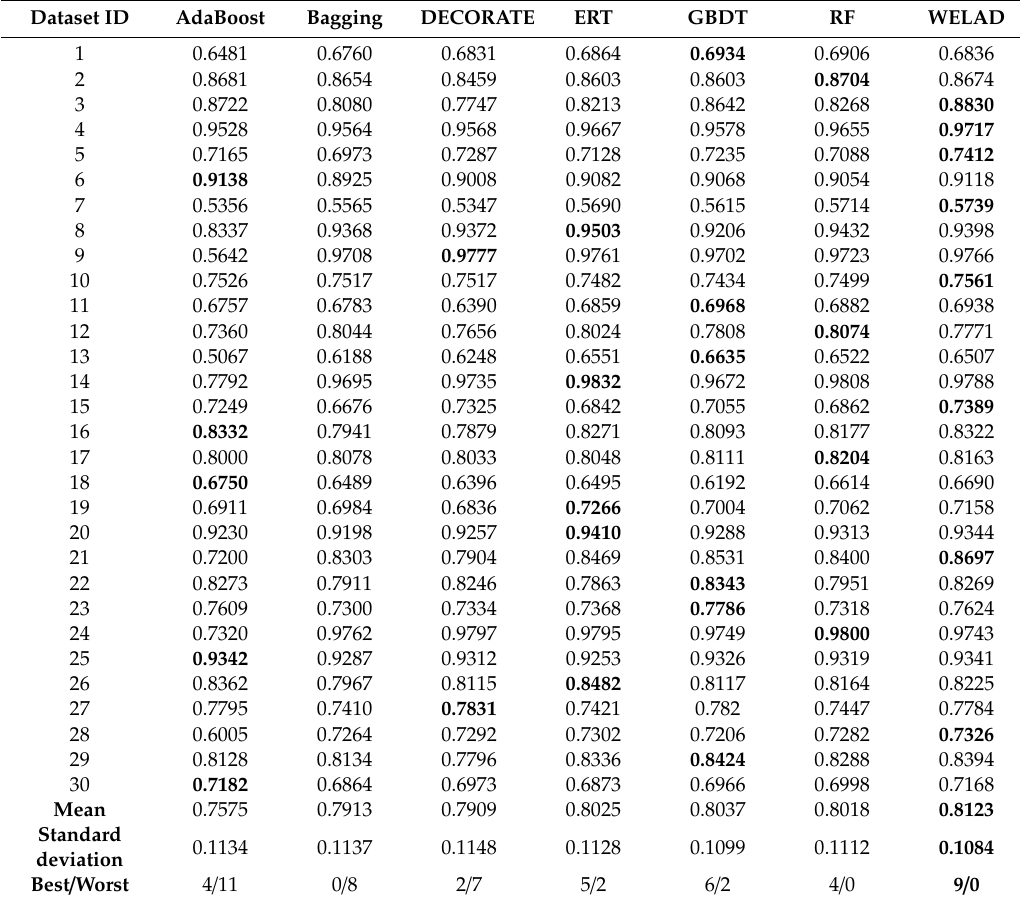
Table 3. Comparison of accuracy on 30